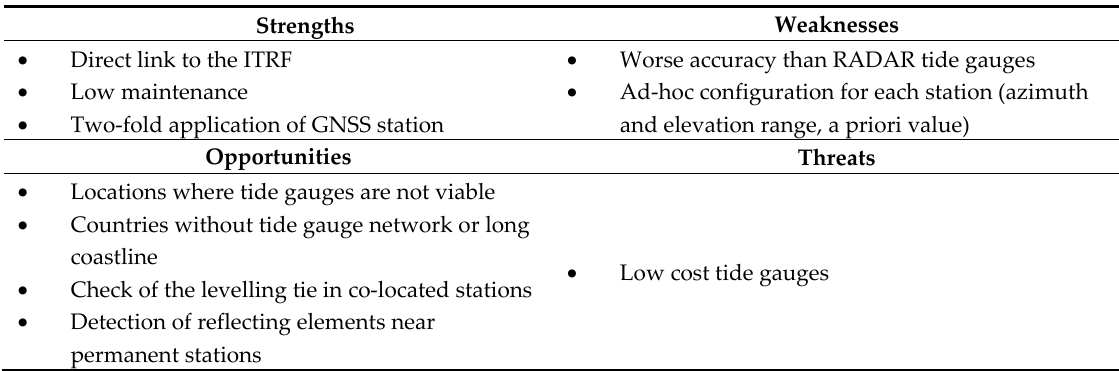
Table 2. SWOT analysis of GNSS-R for sea level